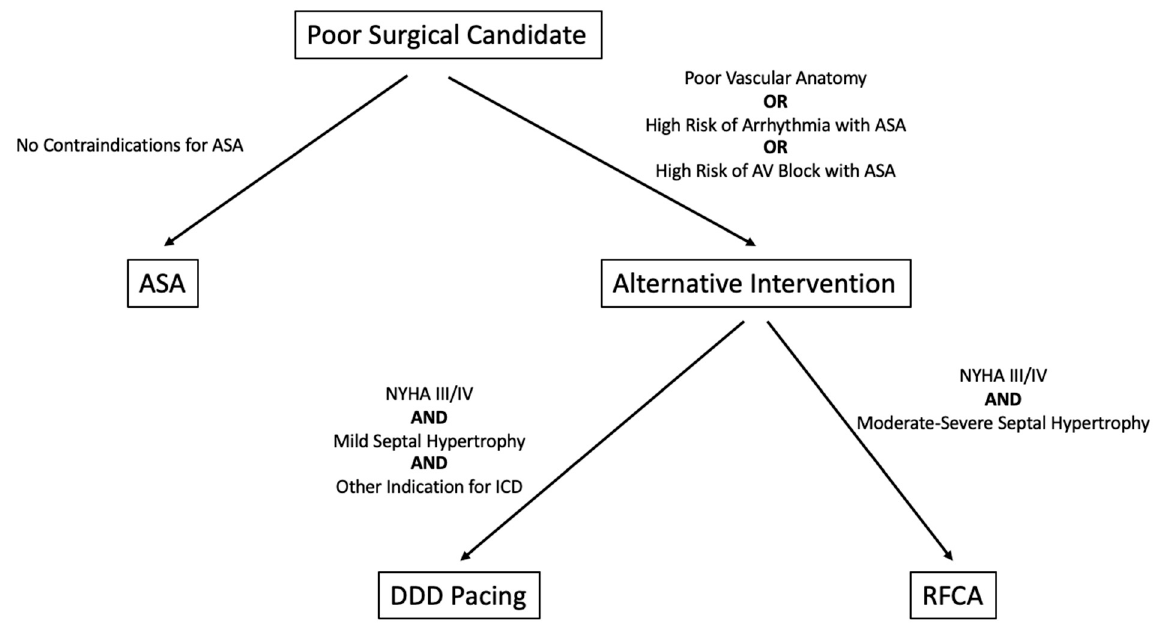
Figure 7. Proposed algorithm for alternative treatments when surgery is contraindicated. At this time, DDD pacing and RFCA are not indicated for the treatment of HOCM by any